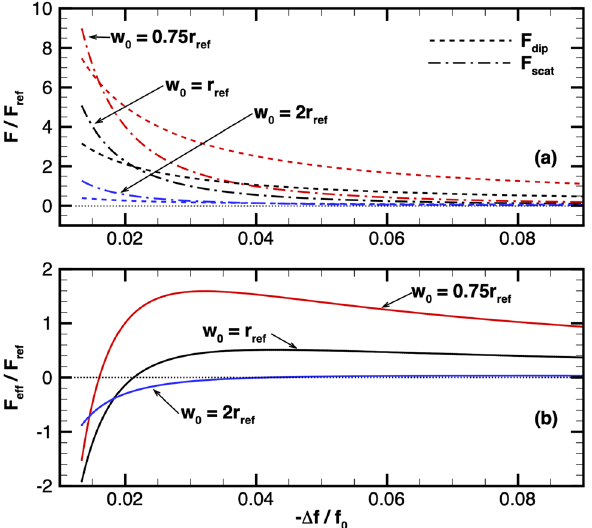
Figure 3. Influence of beam waist and detuning on trapping. ( a ) Both optical forces and ( b ) the effective trapping force over a range of detuning and for a few different beam waists. Light power is 2.2 TW. Note the light detuning below resonance is Doppler-shifted considering a particle beam velocity of 0.1 c , F ref = 2.76 × 10 − N, and r ref = 1